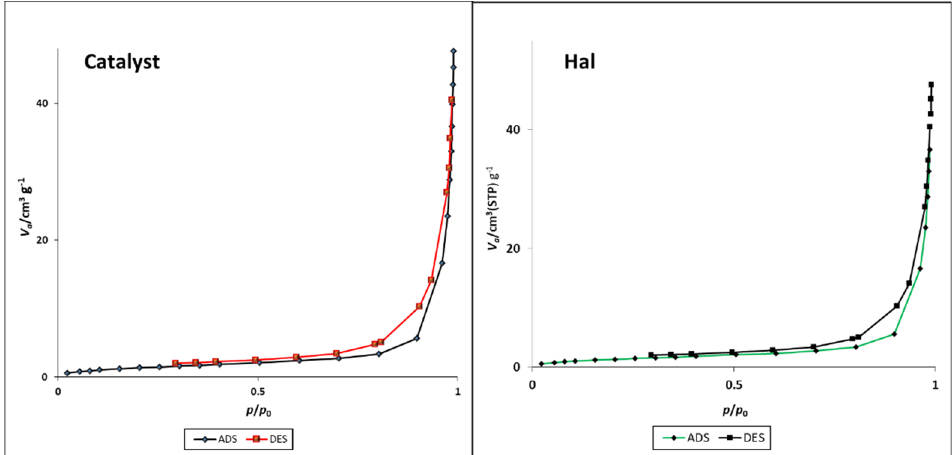
Figure 8 . N 2 adsorption-desorption isotherms of Hal ( right ) and Hal-Py-IL ( left ).